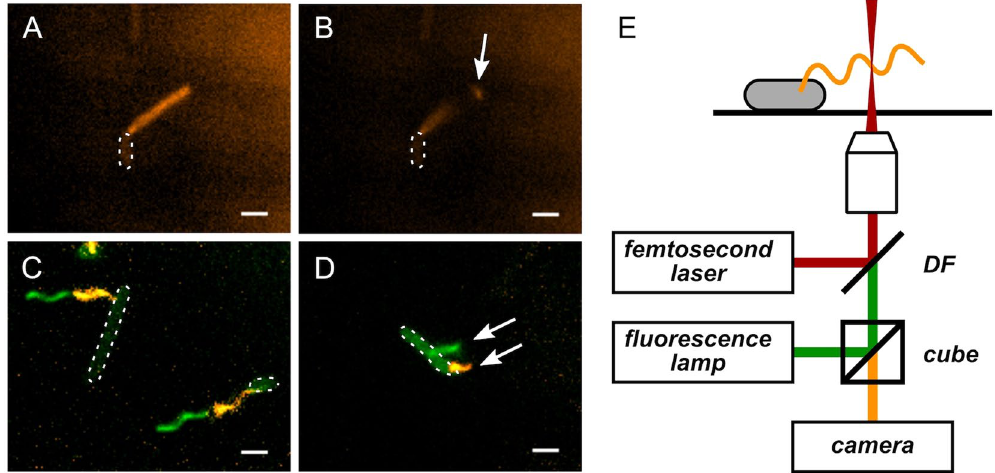
Figure 3. Flagellar filaments broken using ultrashort laser pulses do not re-grow. ( A,B ) Flagellar filament of strain EM800 ( Δ fliO Δ flgM P flhD * fliC T237C ) before ( A ) and after ( B ) being broken by an ultrafast laser beam. The cell body is barely visible (highlighted with white dotted line) and the filament shows up large and fuzzy because it is rotating much faster than the image acquisition rate. The white arrow points to the broken filament segment drifting away and out of focus. Scale bars are 2 µ m. The full movie is available in Supplementary Materials. ( C ) Control cells of strain EM800 whose filaments were left intact after 2-color labeling. The green portions of filaments that grew during incubation are clearly distinguishable. ( D ) Example of a bacterium (EM800) that grew a new flagellum during incubation. The top arrow points to the new filament that grew after the first labeling. The filament is blurry since it was rotating during the exposition. The bottom arrow points to the broken filament (orange) that did not regrow. The continued rotation of the flagellar filament demonstrates that the cell was still alive and potentially able to re-synthesize a new filament. ( E ) Schematic of the experimental setup. The femtosecond laser is added to the optical axis through a dichroic filter (DF) and focused on the sample with a 100 × 1.3 NA objective. The same objective is used for fluorescence imaging. The sample is illuminated with a broadband light source and a fluorescence cube selects the excitation and emission wavelengths. The bacterial filaments are then visualized using an EMCCD camera.